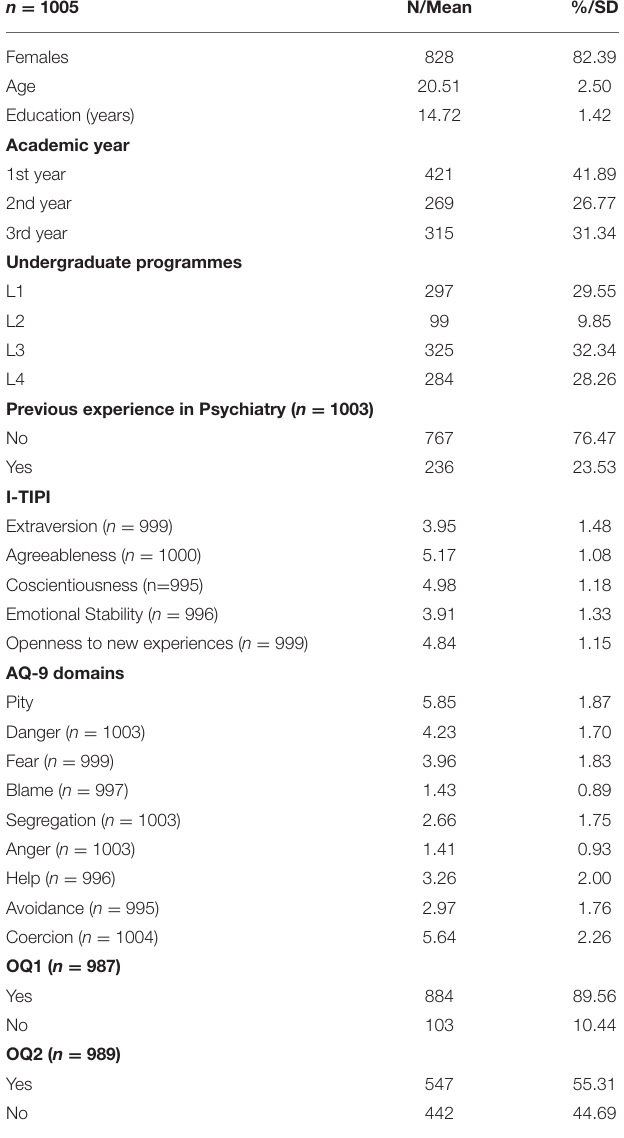
TABLE 1 | Description of the sample, including demographic and academic features, personality traits, AQ-9 domains, and response to the Opinion Questions